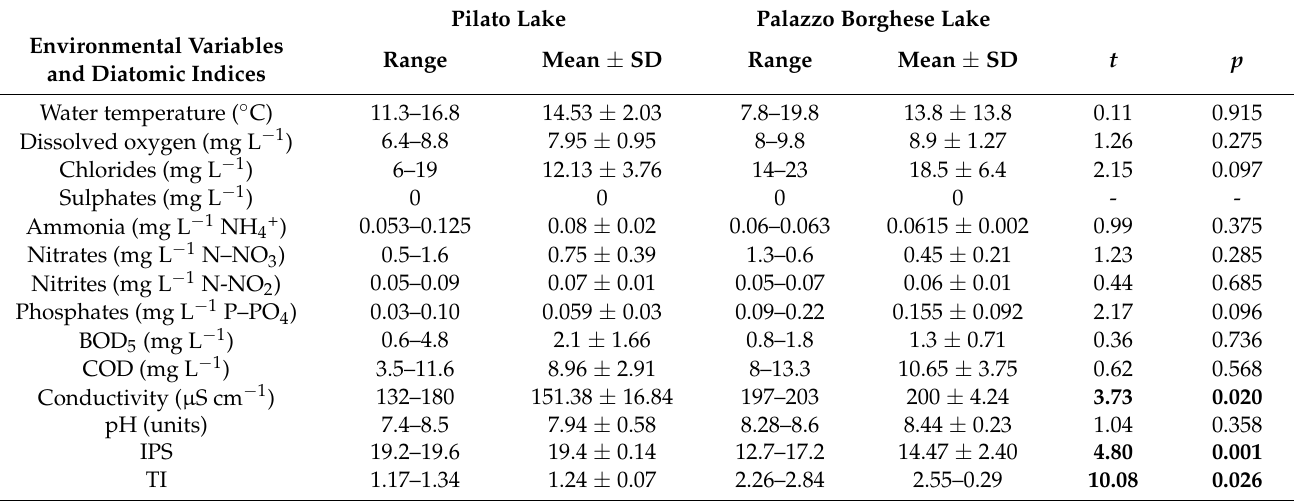
Table 1. t -test analysis for physico-chemical parameters and diatomic indices Pollution Sensitivity Index (IPS) [27] and Trophic Index (TI) [28]: comparison between the Pilato and Palazzo Borghese lakes. p < 0.05 is in bold. Pilato